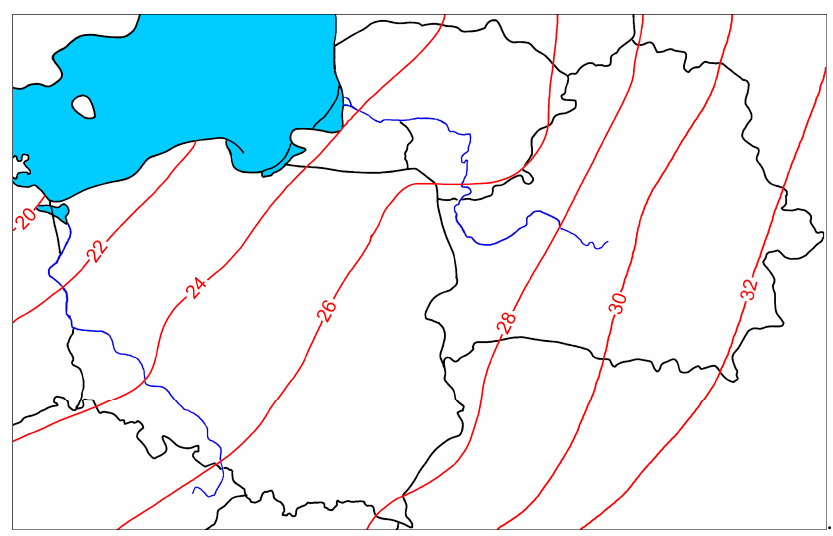
Figure 2. The spatial distribution of the thermal continentalism index according to Conrad (%), (after [21], changed).